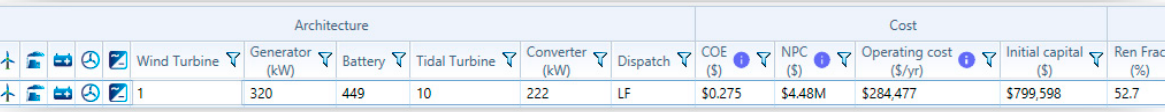
Table 10. Optimization results for balanced alternative scenario 1W + 10T.